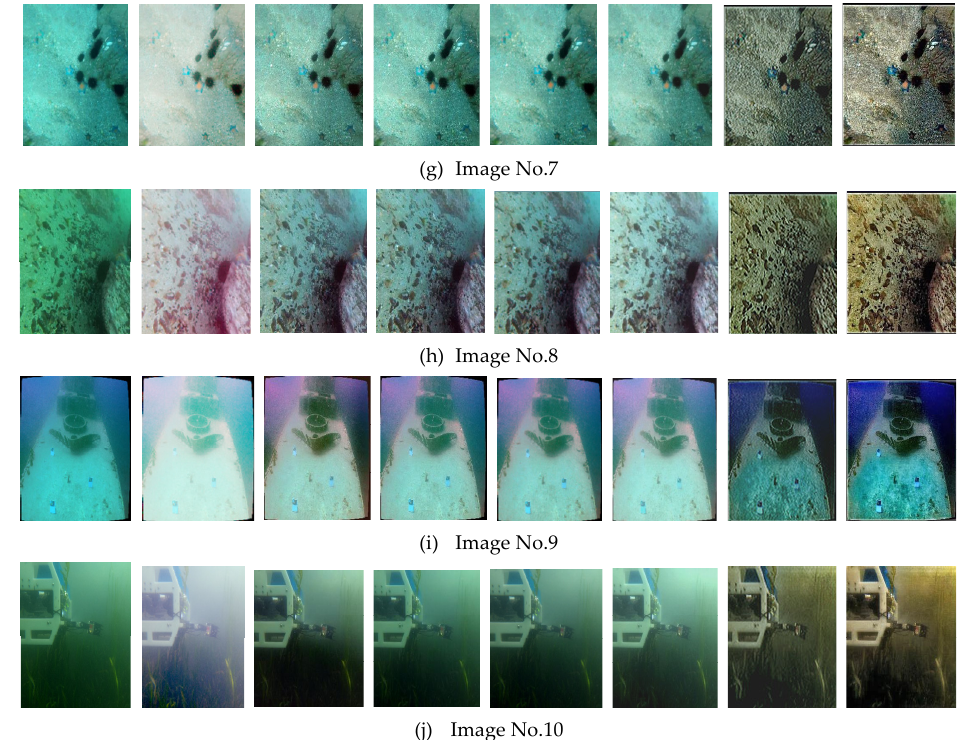
Figure 8. Comparison of visual effect by six algorithms.